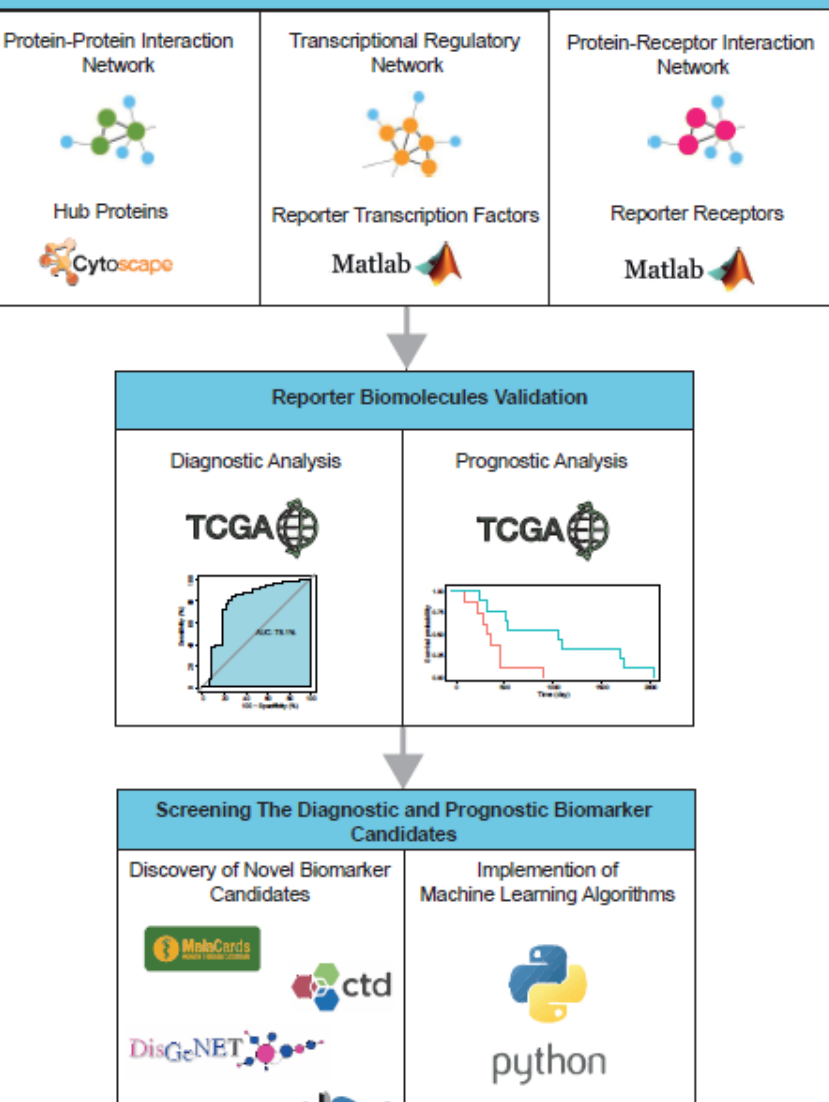
Figure 1. The computational flow employed in the study.